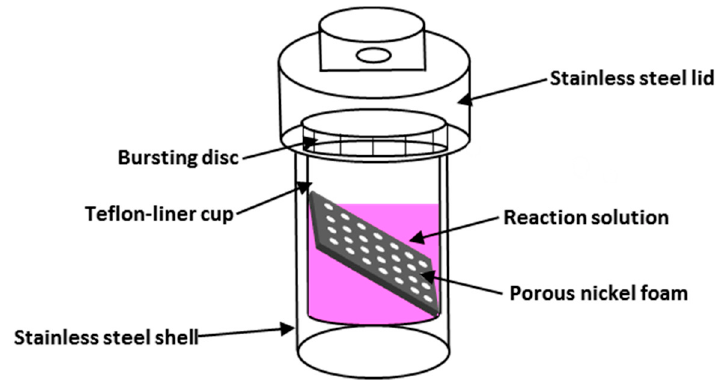
Figure 2. Schematic illustration of the Teflon-liner stainless steel autoclave.